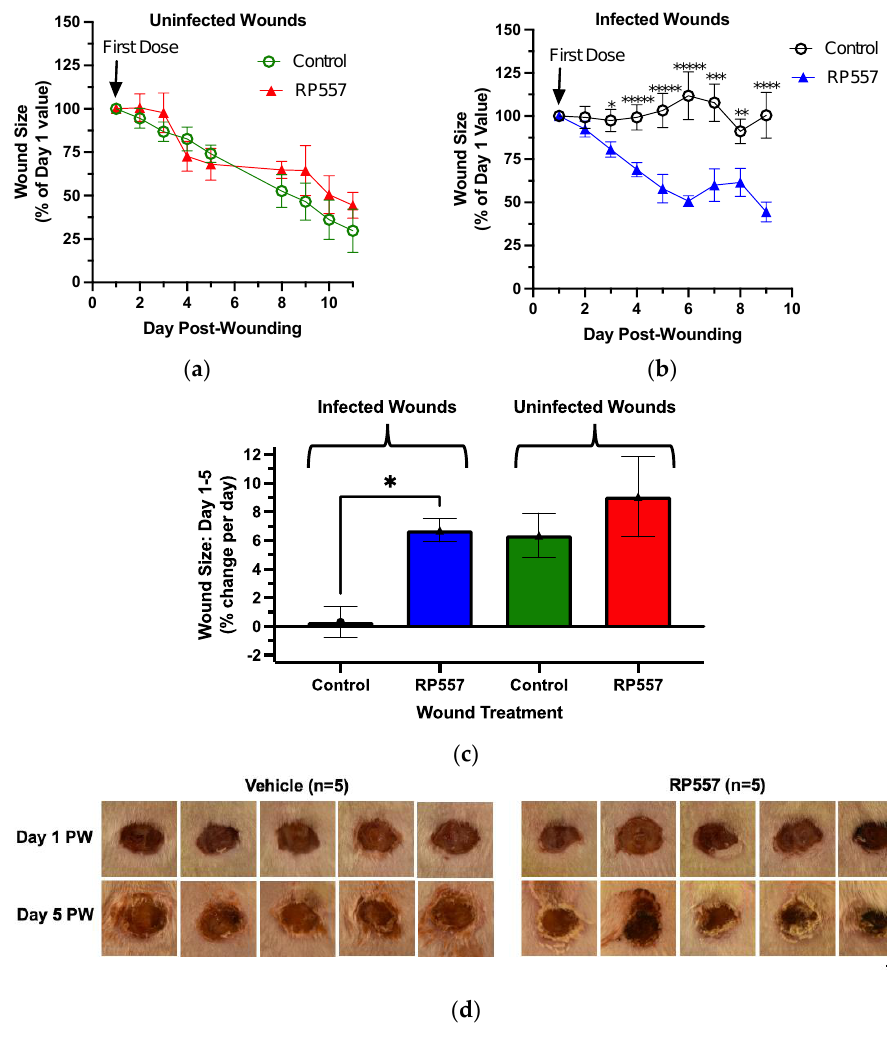
Figure 5. Effect of RP557 on healing of diabetic mouse wounds. TALLYHO diabetic mice were dorsally wounded on Day 0. Starting on Day 1, wounds were treated at each timepoint with control (saline or FBS) or RP557. ( a ) Wound closure of uninfected TALLYHO wounds as percent change relative to the size of the wound on Day 1. In this study, wounds were treated from Day 1 – 5 and Day 8 – 11. Data are from one experiment ( n = 3 – 5 mice per group). ( b ) Wound closure of MRSA-infected TALLYHO wounds as percent change relative to the size of the wound on Day 1. Data are from two independent experiments ( n = 5 – 10 animals per group). ( c ) Slope as a positive value of the simple linear regression line of the data shown in ( a , b ) from Day 1 to Day 5. ( d ) Representative images of the MRSA-infected wounds from ( b ) Day 1 and Day 5. *, **, ***, ****, and ***** denote p - values of <0.05, <0.03, <0.05, <0.005, and <0.003, respectively. Scale bar is 5mm.